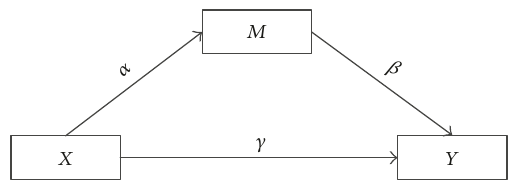
Figure 1: Modeling indirect effect diagram.